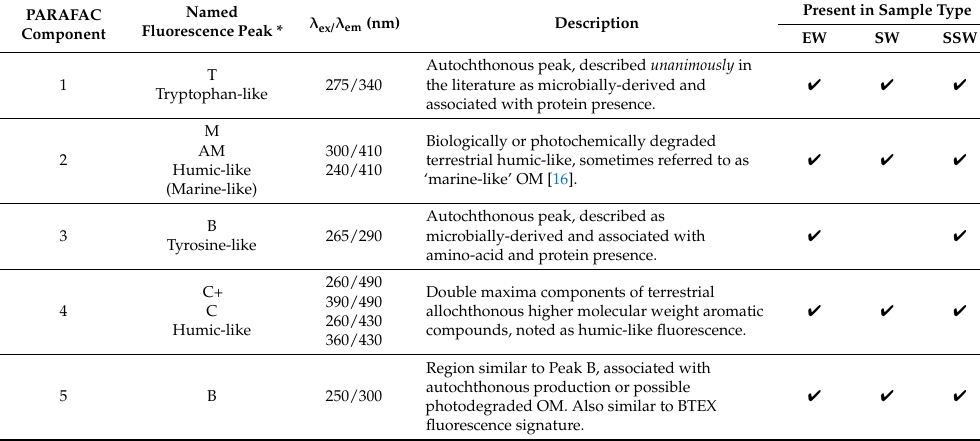
Table 1. Identified parallel factor (PARAFAC) analysis components and fluorescence peaks generated through microbial processing of environmental and synthetic samples over a 10-day experimental period. EW—environmental water samples; SW—synthetic water samples; SSW—supplemented synthetic water samples.